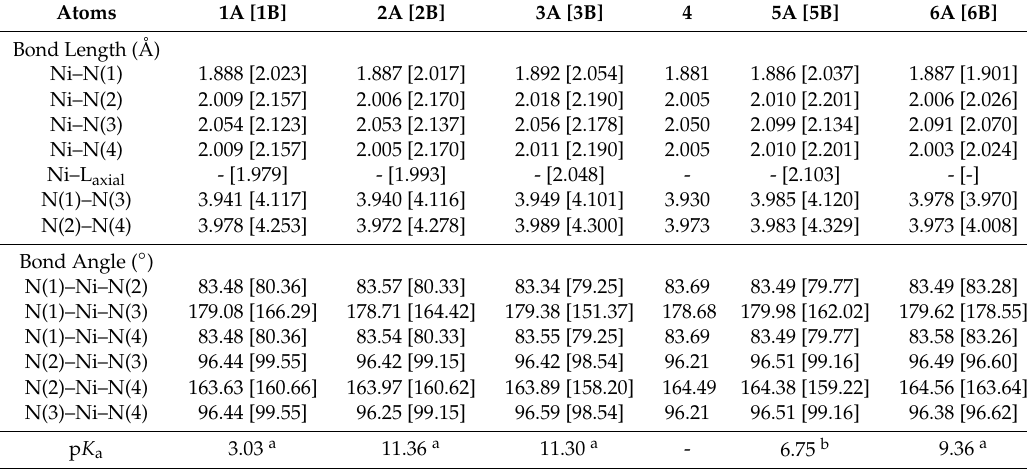
Table 3. Bond lengths (Å) and angles ( ◦ ) for the optimized electronic ground states of protonated